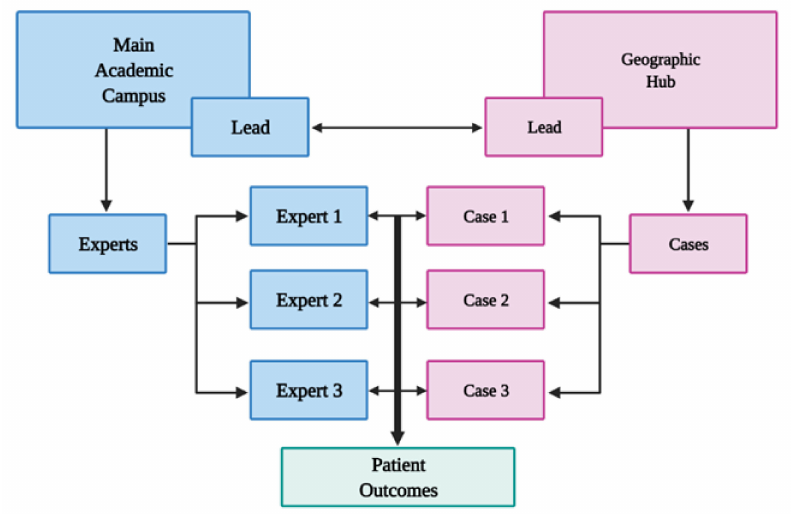
Figure 3. Complex Oncology Case Discussion algorithm for expert collaboration between academic and geographic network